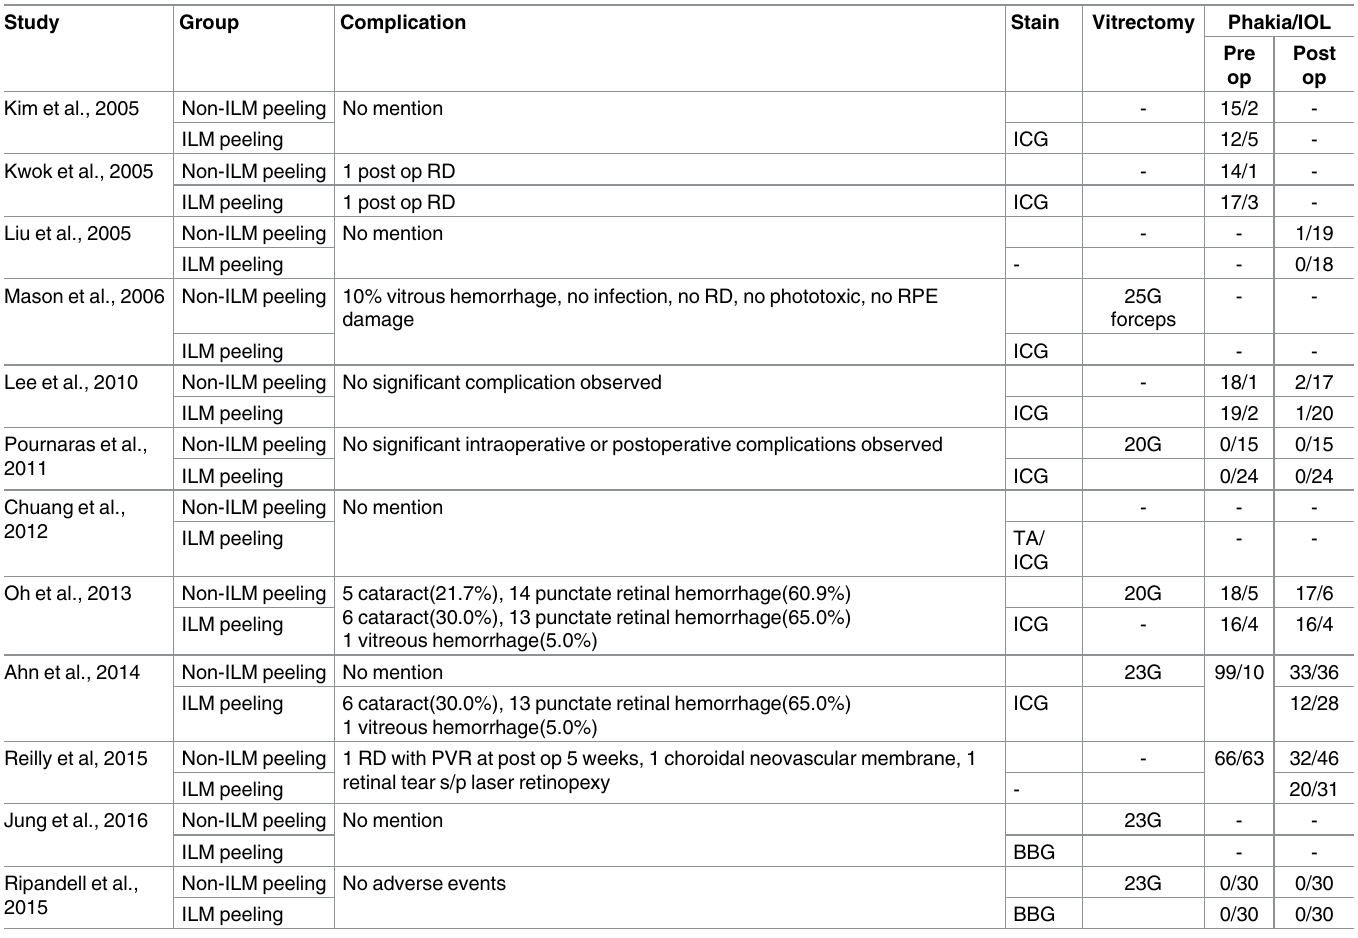
Table 3. Surgery-related features of studies included in the